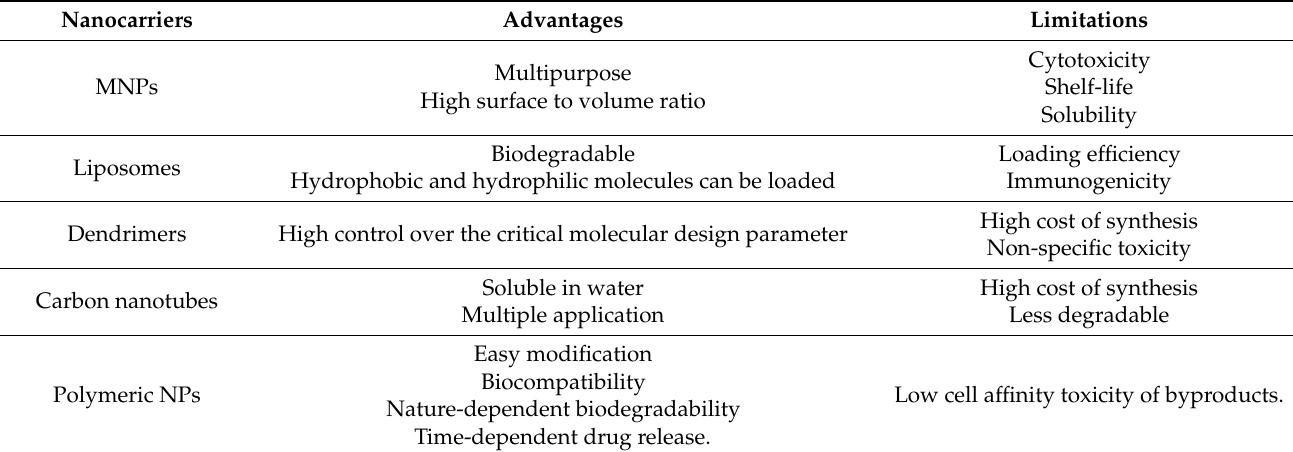
Table 2. Advantages and limitations of various